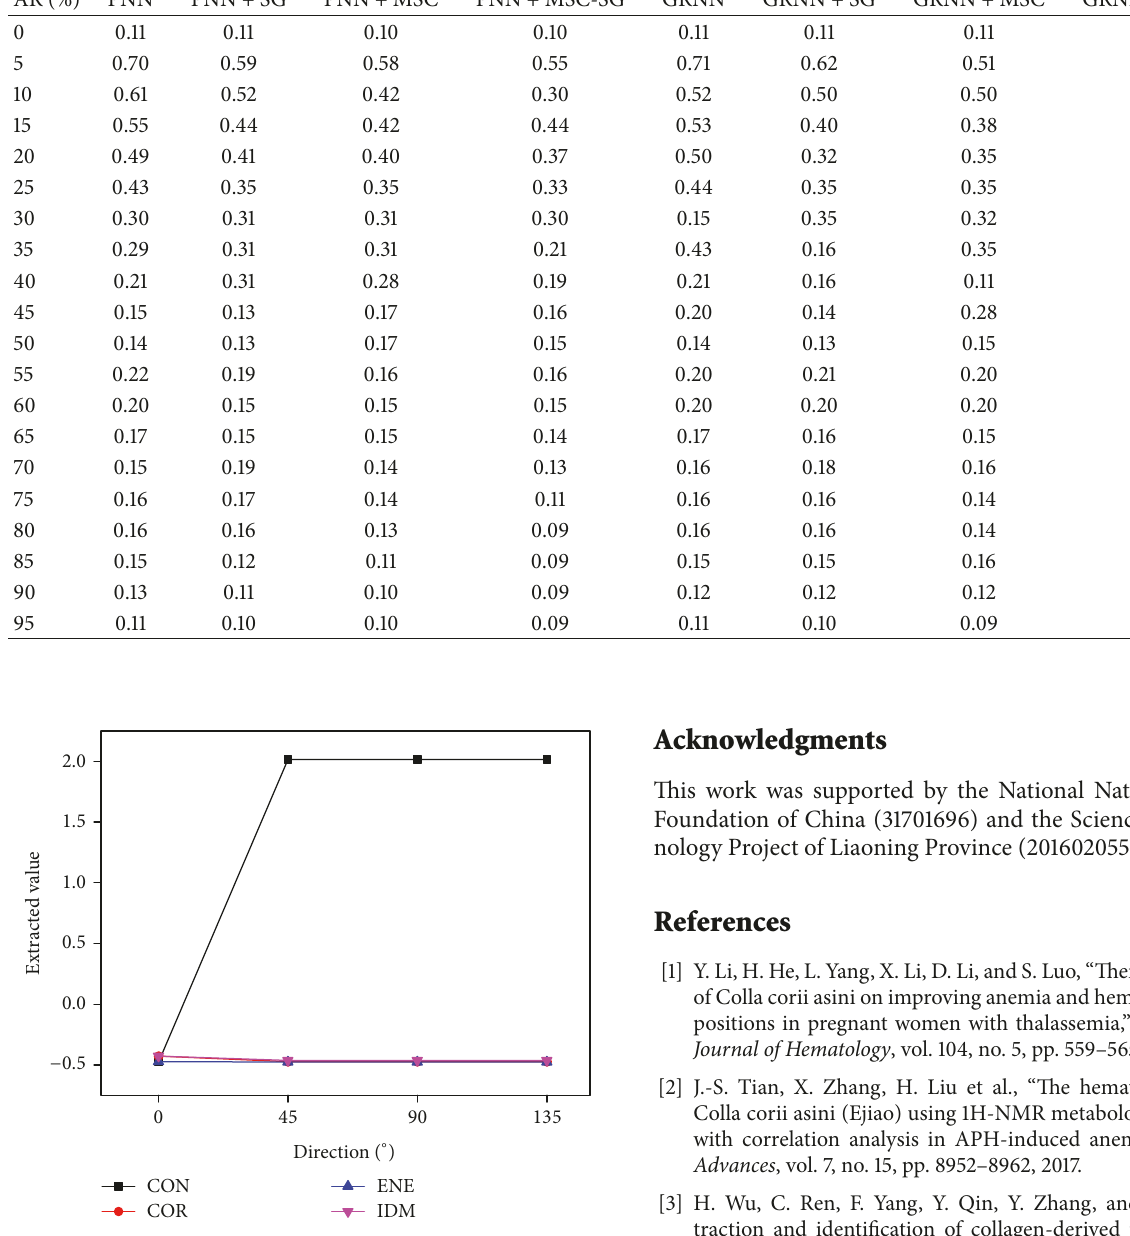
Figure 7: Four texture characteristics from original spectrum at the first CW (695 nm) along different directions for 50% PSG